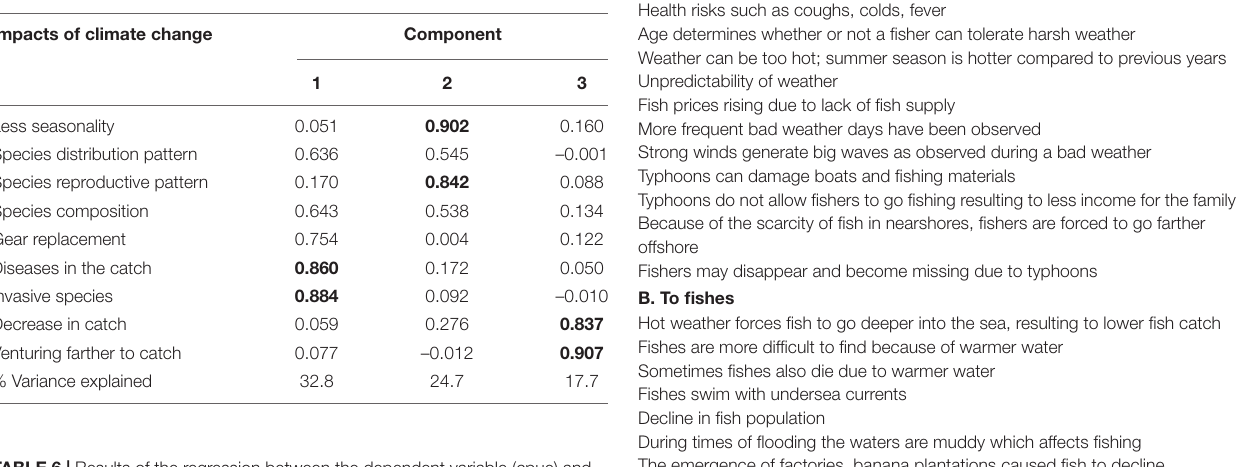
TABLE 5 | Factors loadings of the PCA result of the various variables related to climate change impacts (numbers in bold contribute highly and positively to a component).